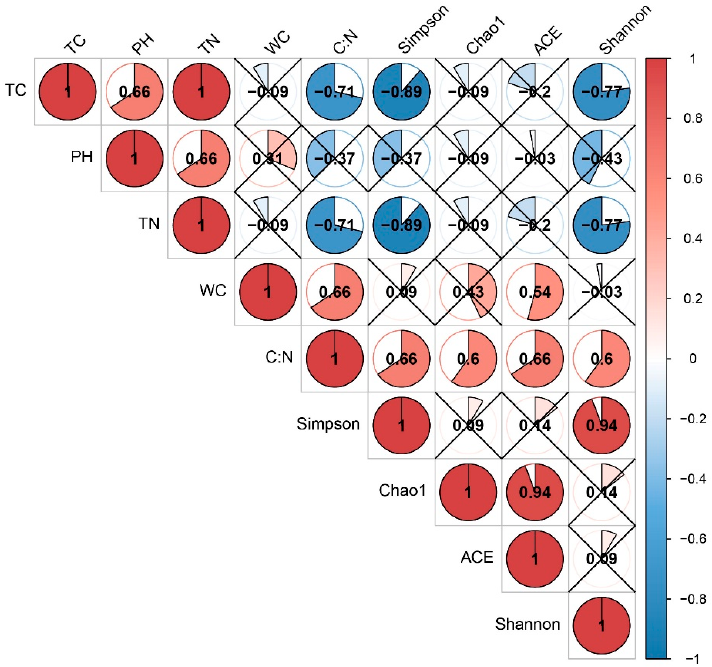
Figure 2. Correlations among soil properties and soil bacterial diversity indices. Blue and red indicate positive and negative correlations, respectively; the extent of circle shading represents the strength of the correlation coefficient, and crosses in the circles indicate insignificant correlations ( p > 0.05).